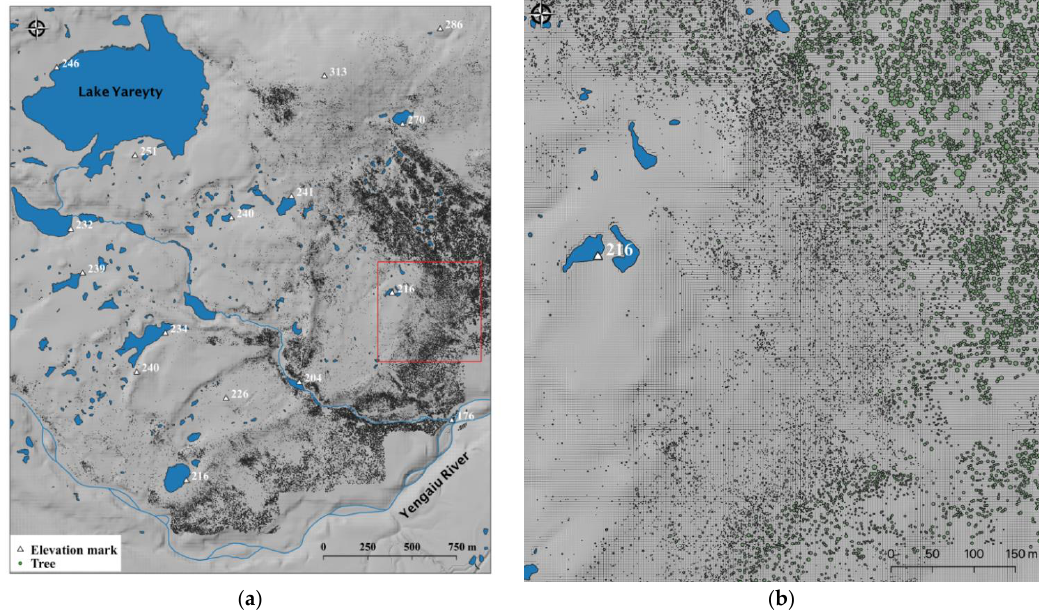
Figure 4. Distribution map for the specimens of Siberian larch in the upper treeline ecotone, developed by deciphering aerial images captured with a drone ( a ), and an enlarged fragment (shown on Figure 4a with a red rectangle ( b )).